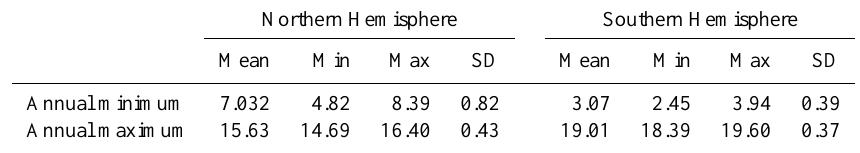
Table 3. Statistical characteristics of annual minimum and maximum of CDR sea ice extents (million square kilometers). Northern Hemisphere